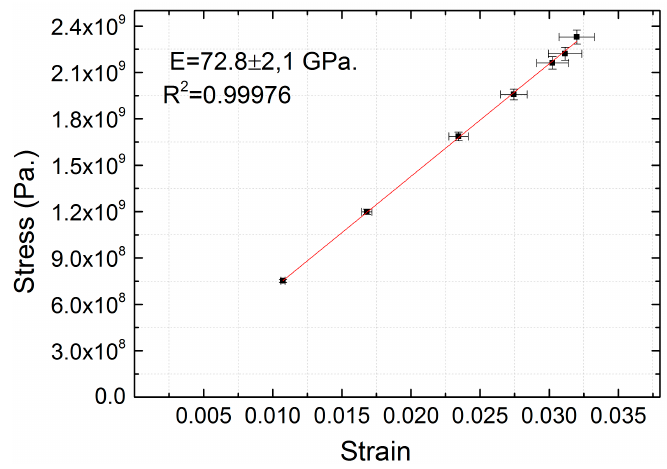
Figure 11. Stress map of the test beam just before its failure. The stress is uniformly distributed along the length and the thickness of the test beam.